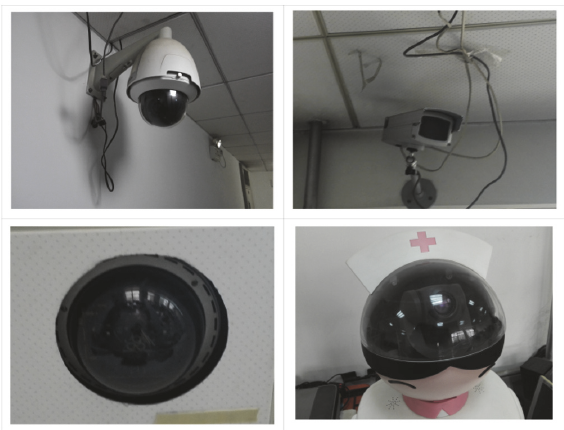
Figure 5: Illustration of cameras in intelligent space system.